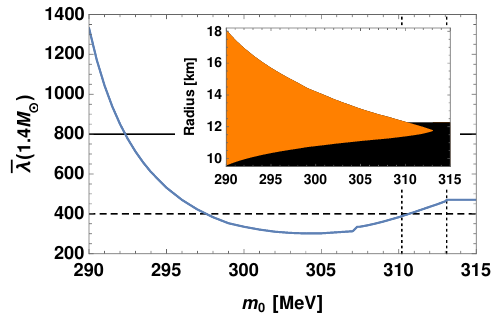
Figure 5 . The tidal deformability of a (lower-radius) 1 : 4 M (cid:12) star as a function of m 0 . Shown here are also horizontal lines denoting the values (cid:22) (cid:21) (1 : 4 M (cid:12) ) = 800 and 400, corresponding roughly to the 90% and 50% probability limits of LIGO and Virgo (cf. discussion in [89]). The cusp in the curve around m 0 = 307 MeV is due to the matched EoS becoming sensitive a small discontinuity in the hadronic EoS of [45]. Inset: internal structure of hybrid stars of mass 1 : 4 M (cid:12) , with the orange (black) color again representing quark (nuclear) matter. Vertical lines in the main plot indicate the transitions from HS2 to HS3 and from HS3 to NS as m 0 increases. The transition from QS to HS2 happens for lower values of m 0 than the ones shown in the plot.